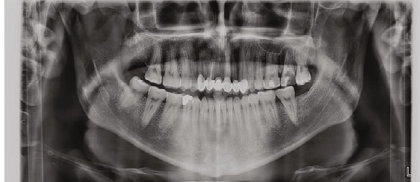
Figure 2: Orthopantomogram before treatment showed the upper left second molar opened with periapical radiolucency.